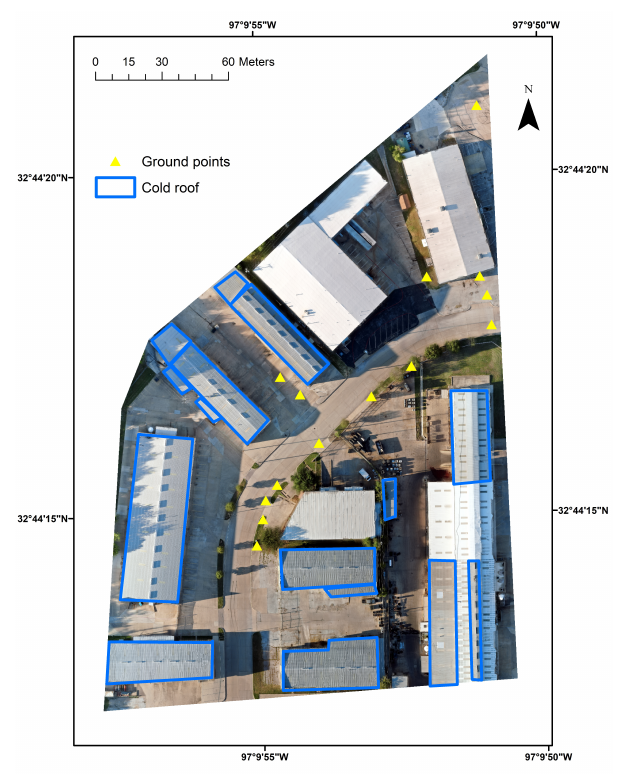
Figure 3. In-situ LST measurement points (yellow triangles) and cold roofs (blue polygons) in